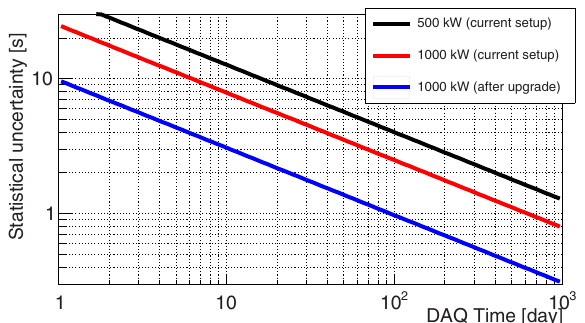
Figure 9. Expected statistical uncertainties as a function of the total data acquisition time. After the SFC upgrade, the neutron beam intensity is estimated to increase by 5.3